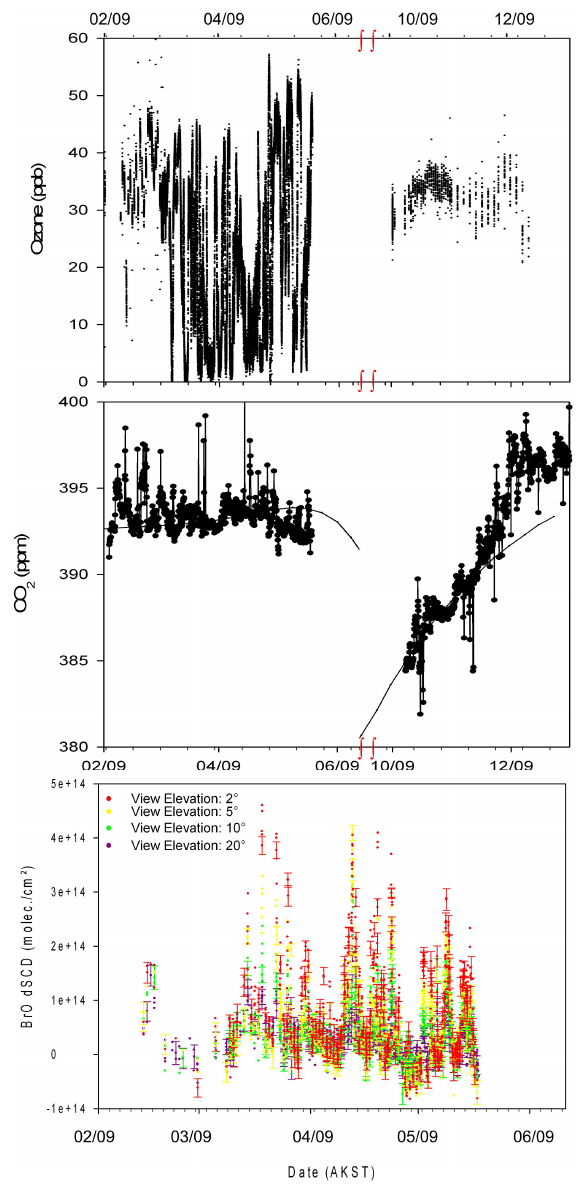
Fig. 7. Data plots from the three major instruments on the O-buoy (O 3 , CO 2 , and BrO) during the entire test phase deployment and the current Beaufort Sea deployment (date in mm/yy). The ozone and CO 2 plots’ abscissas are broken after 06/09, as indicated by ∫∫ . Note, BrO is plotted for only the spring period due to inadequate sample time (result of low sunlight) during the Fall deployment. The smoothed line in the CO 2 plot is a NOAA derived decadal av-